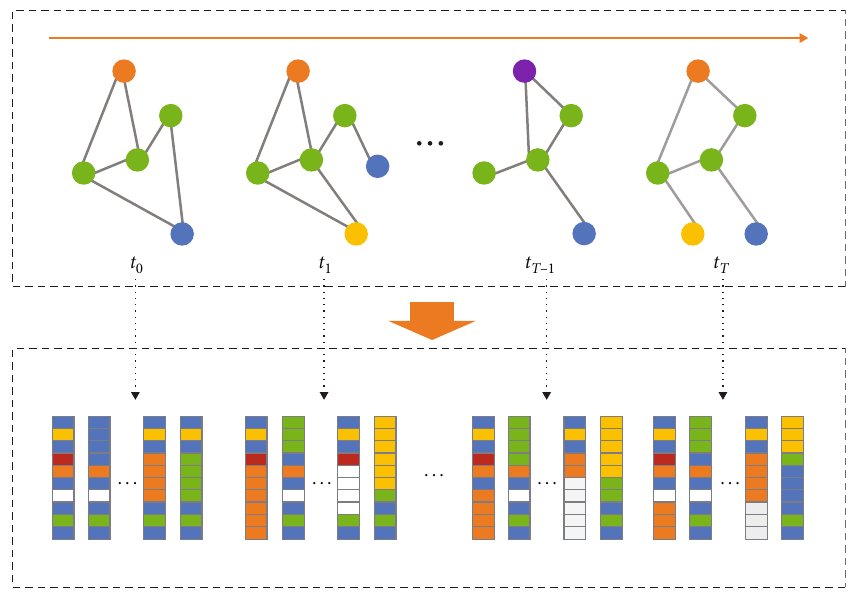
Figure 5: Tra ffi c knowledge graph pretraining.